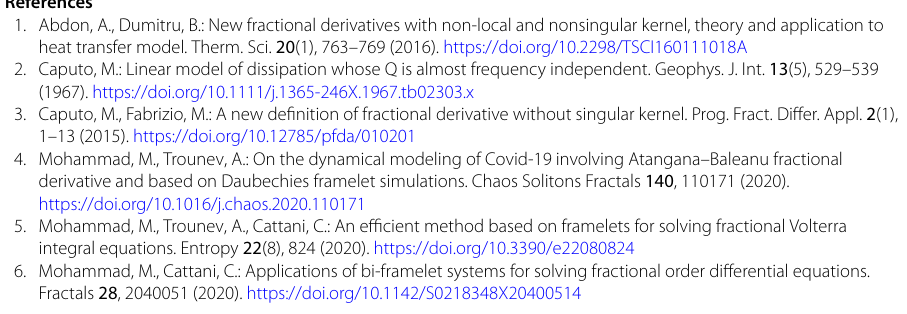
where the resulted integrals are approximated using the composite trapezoidal rule. The obtained results indicate that the method produces high accuracy order and reliable re- sults with only a few terms of the truncated framelet partial sums with a proper discretiza- tion. We have also supported our results by some graphical illustrations of the exact and approximate solutions and provided error bounds of the solved